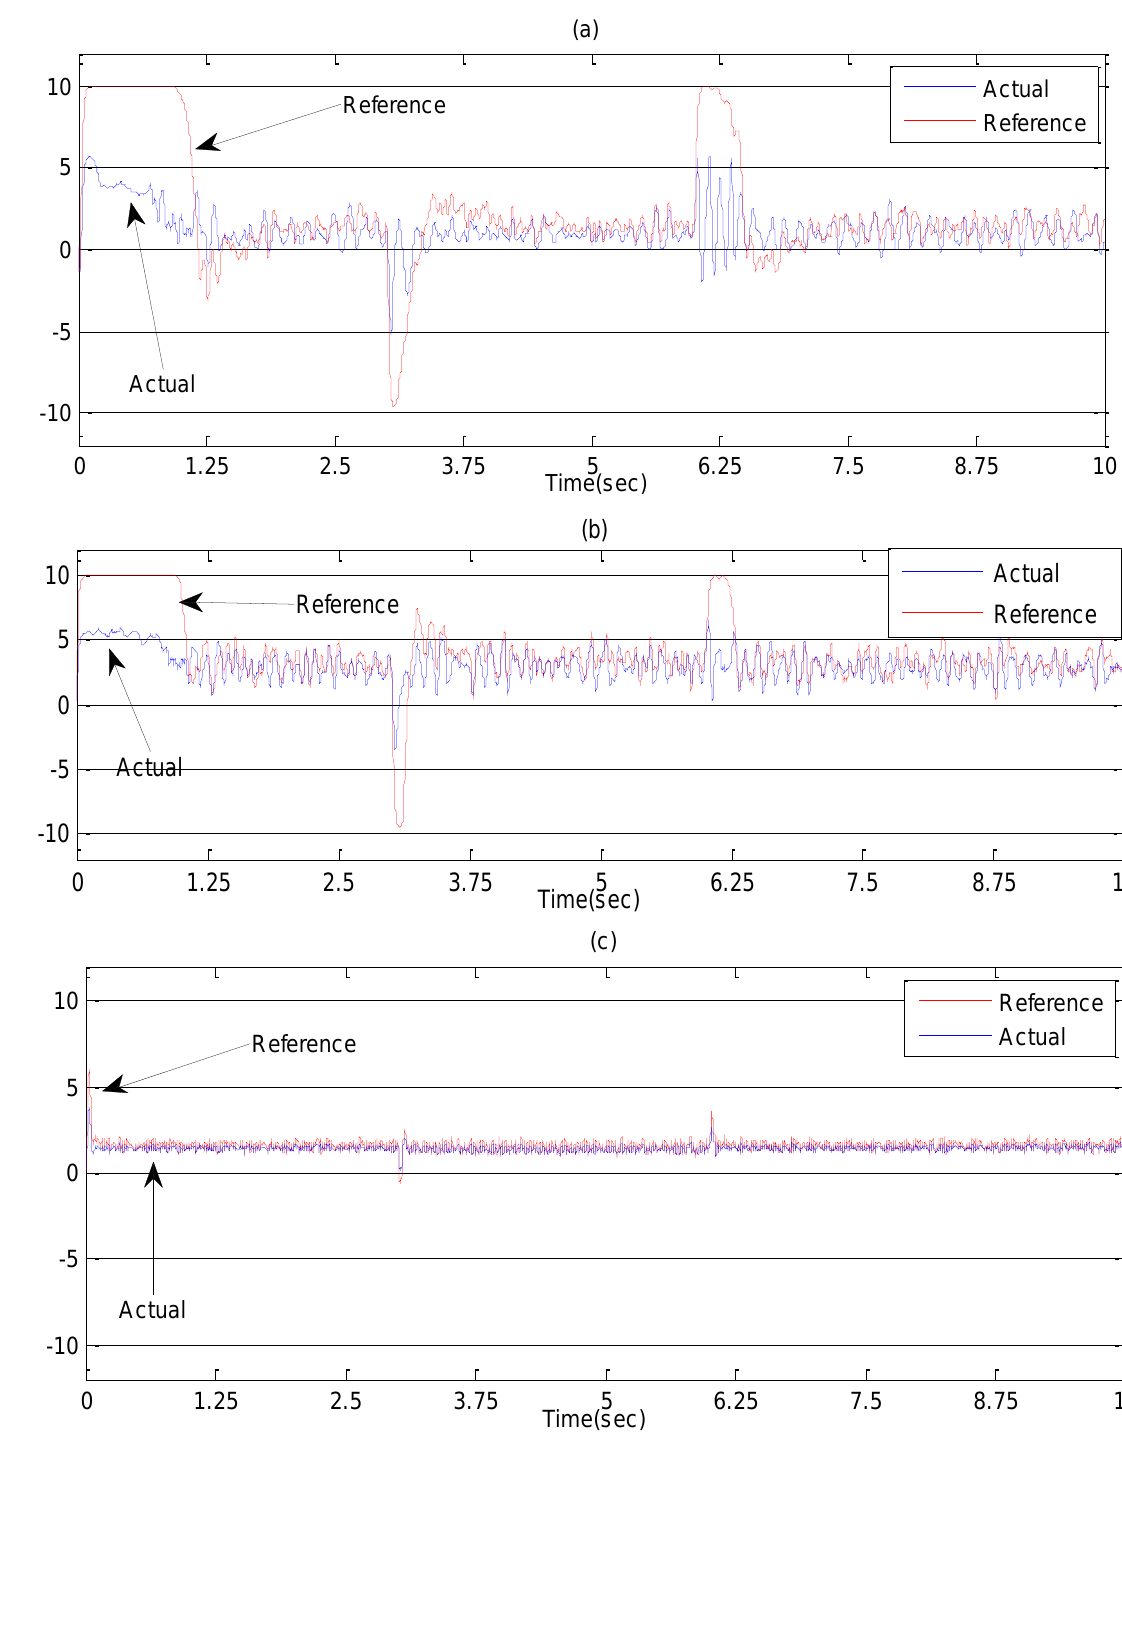
Figure 18. Experimental q-axis current responses based IM drive in Case-1 ; ( a ) the tuned PI controller, ( b ) the conventional BLFC controller , and ( c ) the proposed NBLFC